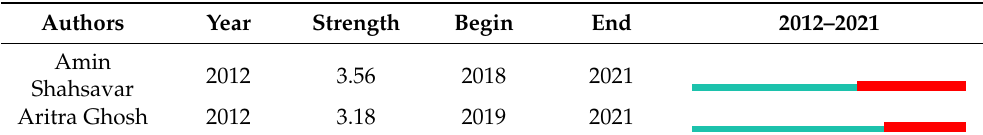
Figure 2. Co ‐ occurrence map of the authors’ collaboration. Table 1. The top two authors with the strongest citation Table 1. The top two authors with the strongest citation bursts.